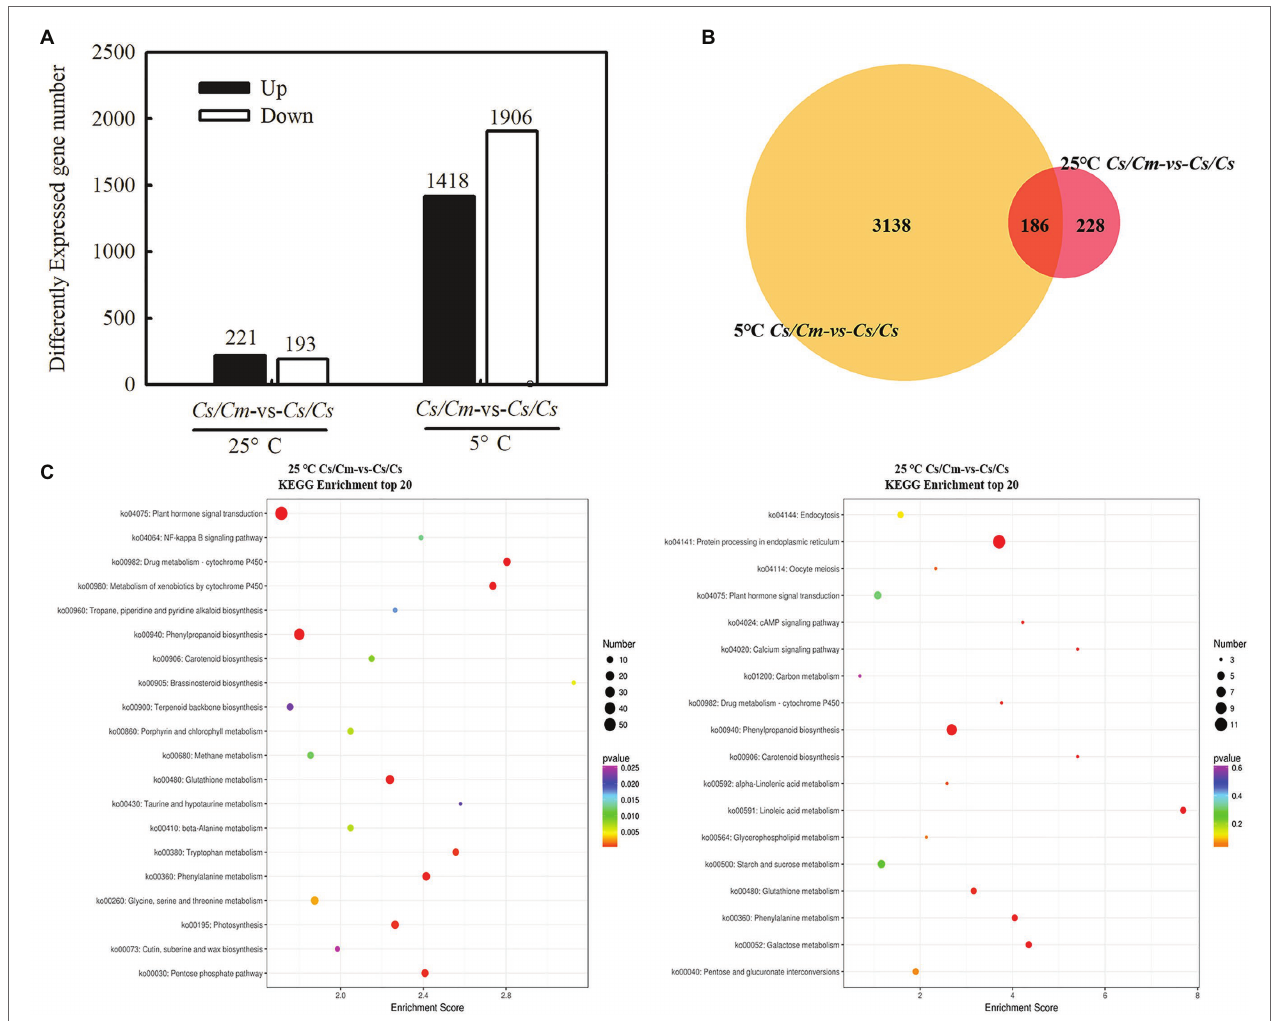
FIGURE 4 | Comparison of gene expression and statistics of pathway enrichment. (A) Differentially expressed genes (DEGs) numbers ( p ≤ 0.05 and fold change ≥ 2) between Cs/Cm and Cs/Cs ; (B) Venn diagram; and (C) the DEG statistics of the Kyoto Encyclopedia of Genes and Genomes (KEGG) pathway enrichment on Cs/Cm vs. Cs/Cs under normal and chilling condition. The top 20 pathways with the most minimum values of p were displayed. The circle represents the gene number of the KEGG pathway. The circle color represents the genes enrichment degree of the KEGG pathway. Three-leaf stage seedlings were sampled at 0 or 12 h after chilling